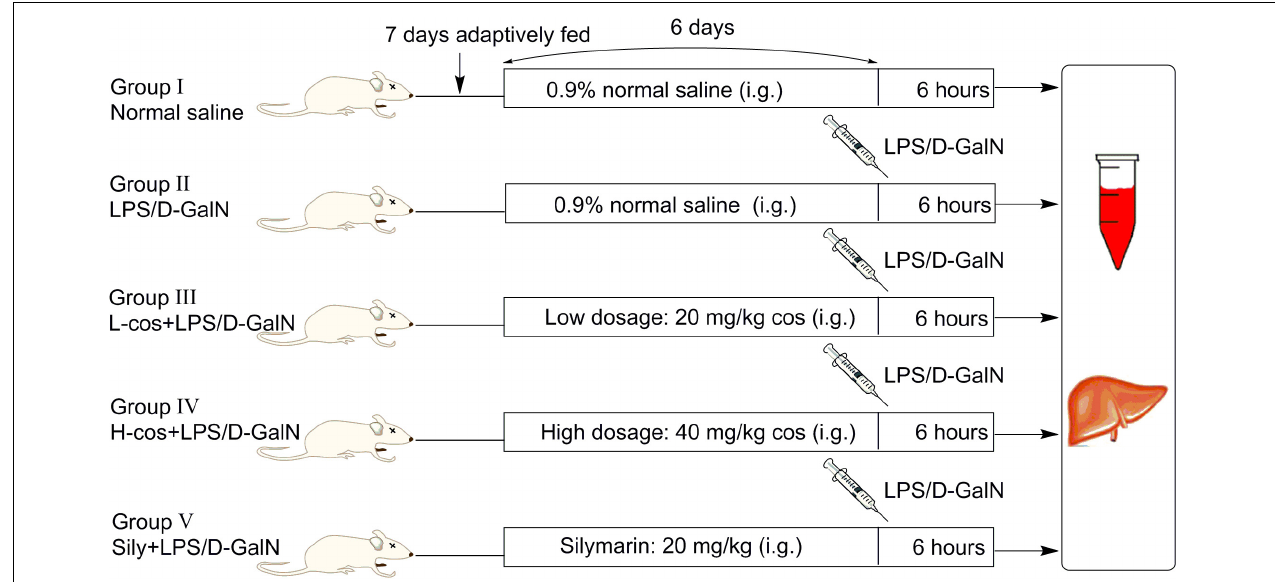
FIGURE 2 | The diagrammatic of mice experiment.